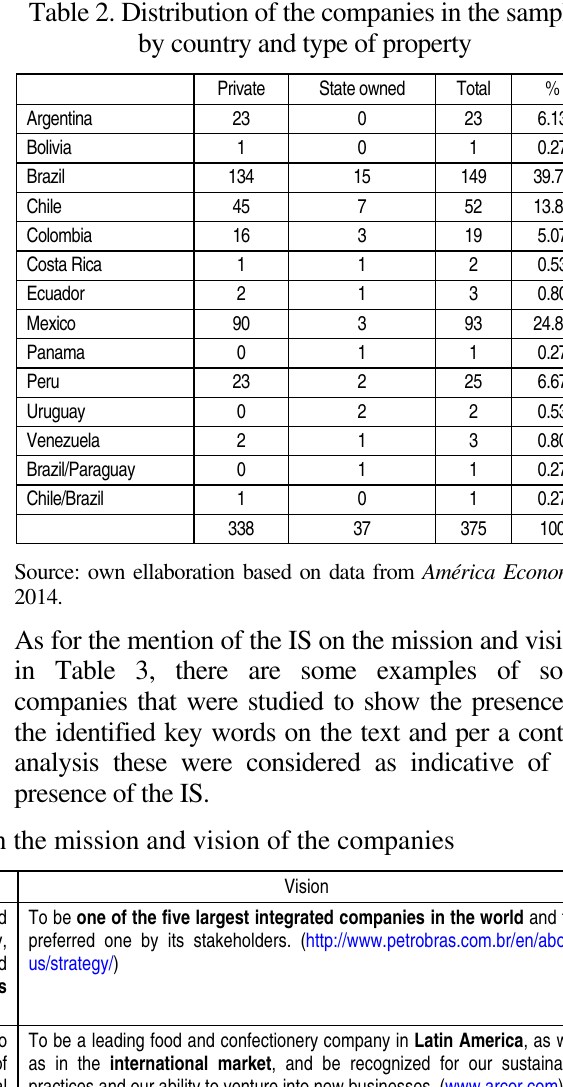
Table 2. Distribution of the companies in the sample